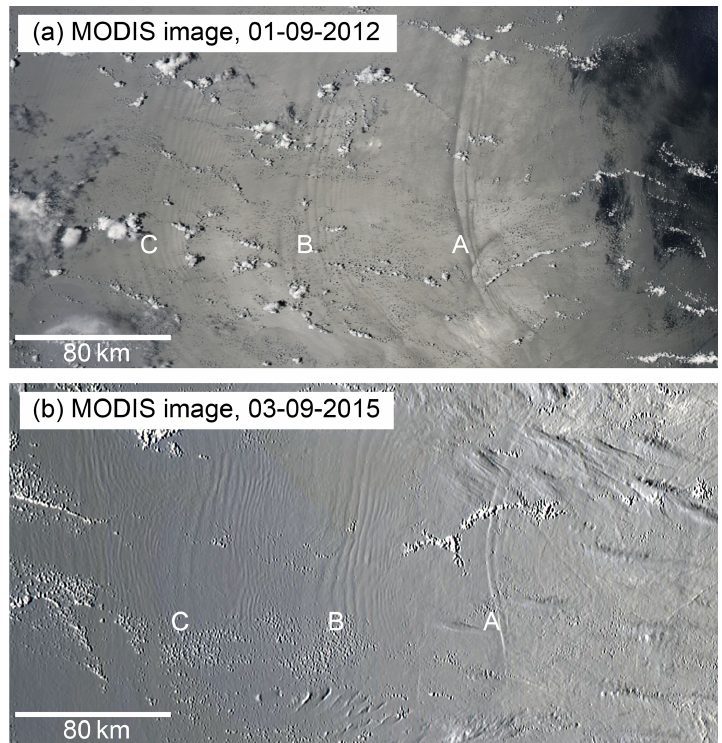
Figure 11. Internal wave packets in MODIS imagery from the Aves escarpment. MODIS Sun-glint imagery from dates in (a) 2012 and (b) 2015 (digitally enhanced) exhibits the surface expression of three packets of internal waves, at longitudes marked A, B, and C. Re- markably, similar wave packets are visible in imagery from 5 September 2018 (not shown). The largest packet, A, is located at Aves Ridge (14 ◦ 20 (cid:48) N, 296 ◦ 30 (cid:48) E) on the Aves escarpment.